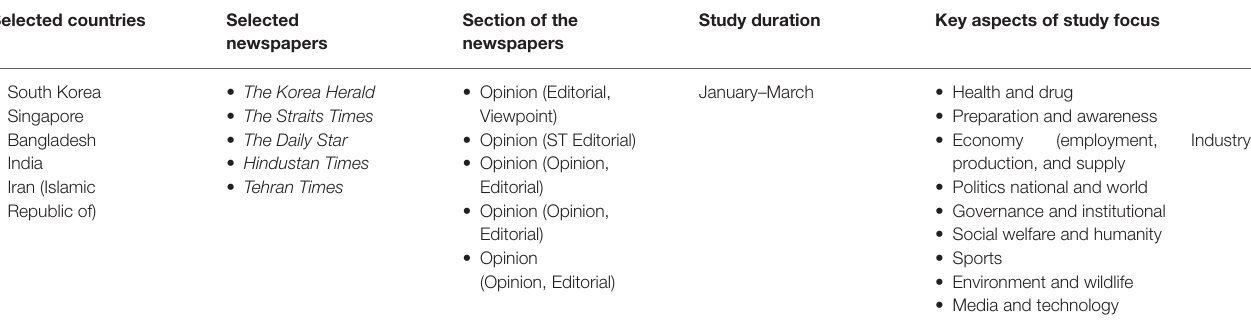
TABLE 4 | Study’s scope on the role of print media in five Asian countries in the COVID-19 pandemic. Selected